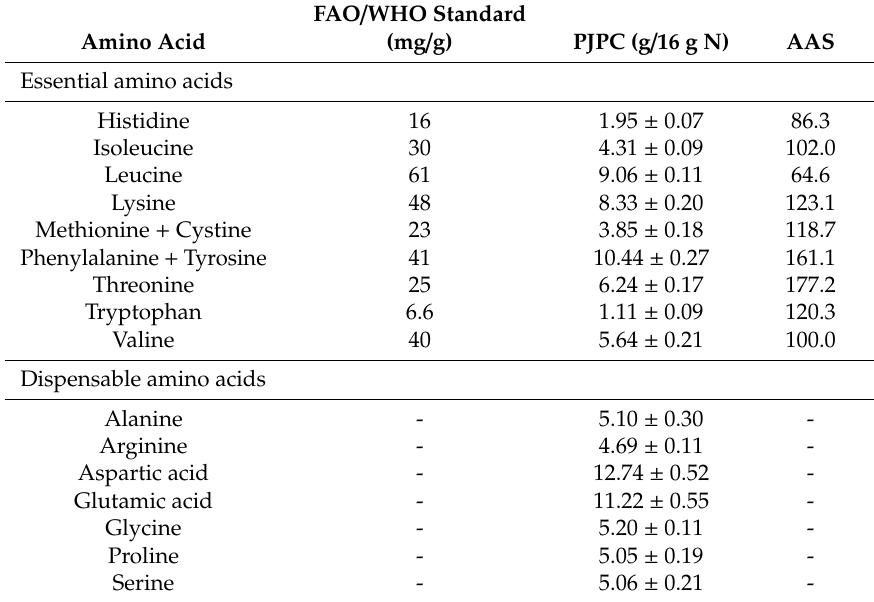
Table 2. Amino acid profile and amino acid score (AAS) for adults according to standards reported by the FAO / WHO [40].